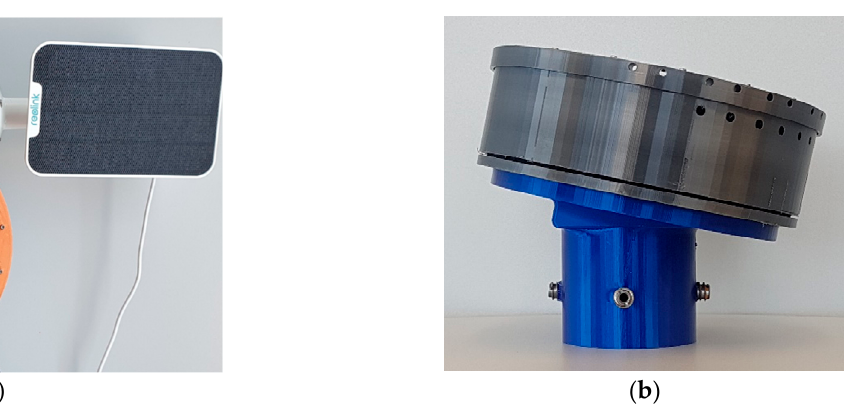
Figure 7. Measured frequency of the resonant circuit for distances between 2–3 mm.